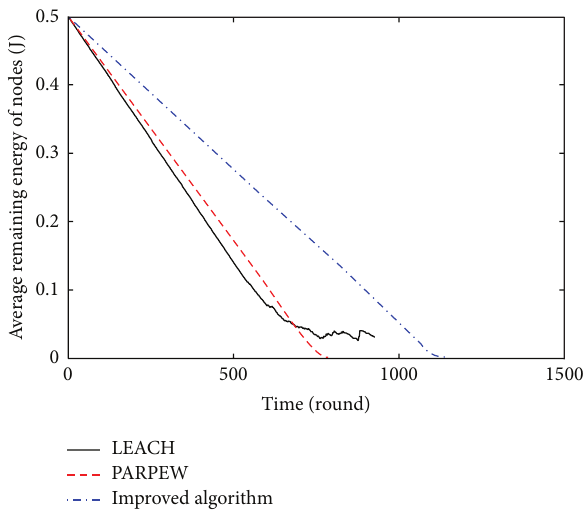
Figure 7: Comparison of the remaining energy average.